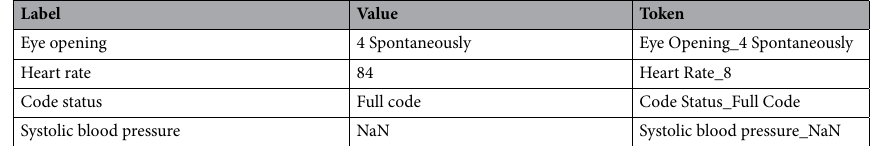
Table 1. Examples of discrete token creation alongside percentile-based quantization and tokenization of continuous variables. Discrete variables remain discrete, while values that can be converted to floating point numbers are considered continuous and separated into percentile-based bins. Our pipeline is simply: convert non-NaN numeric values to percentiles, everything else is considered discrete.